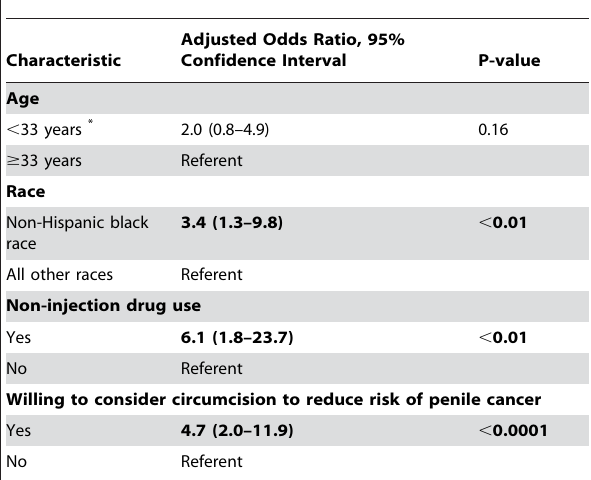
Table 3. Willingness to be circumcised among 127 uncircumcised men who have sex with men not known to be HIV-infected who attended Gay Pride and Minority Gay Pride events in 7 U.S. cities –